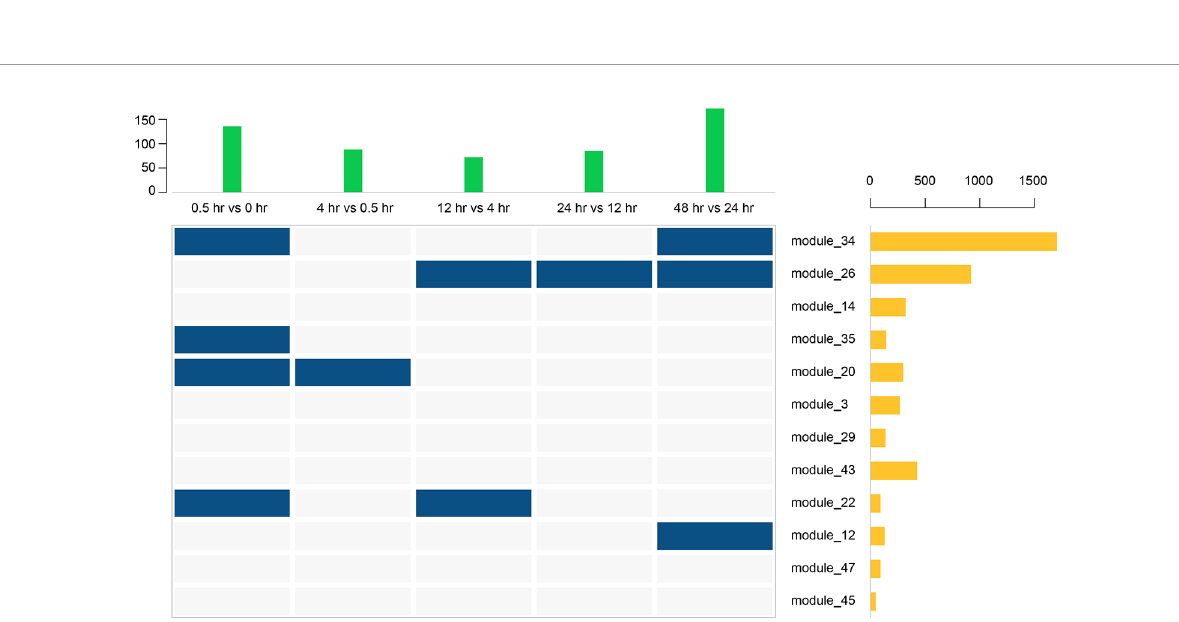
FIGURE 9 | Enrichment analysis between 12 gene modules and 5 DEGs. The above bar chart represents the number of DEGs in each period, and the bar chart on the right represents the number of genes in each gene module. Blue squares represent a signi fi cant enrichment between the row set and the column